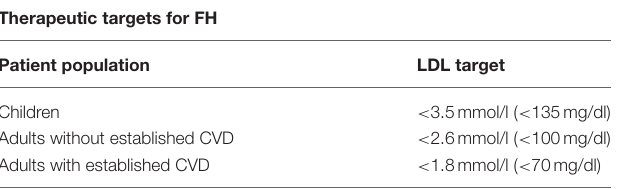
TABLE 8 | Therapeutic targets for familial hypercholesterolemia (2016 ESC/EAS Guidelines for the Management of Dyslipidemias). Therapeutic targets for